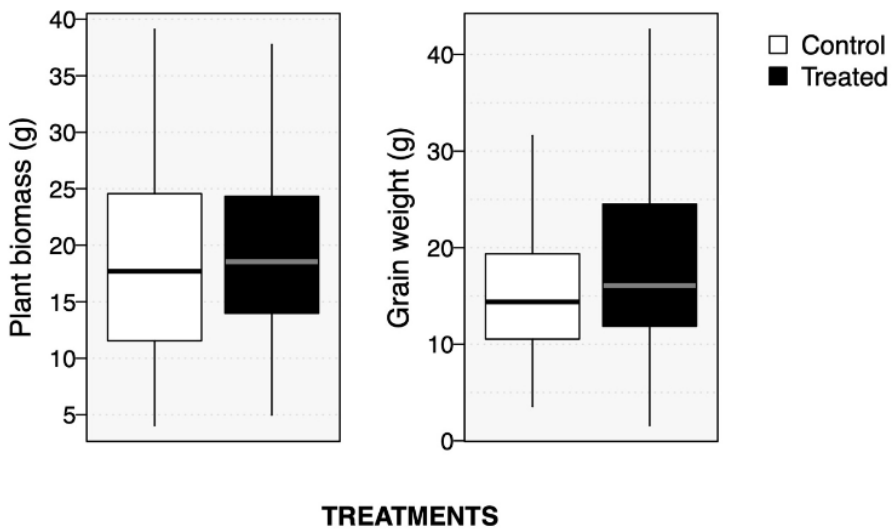
Figure 3. Boxplots showing plant growth (left) or yield (right) in control plots (red) or treated plots (cyan).